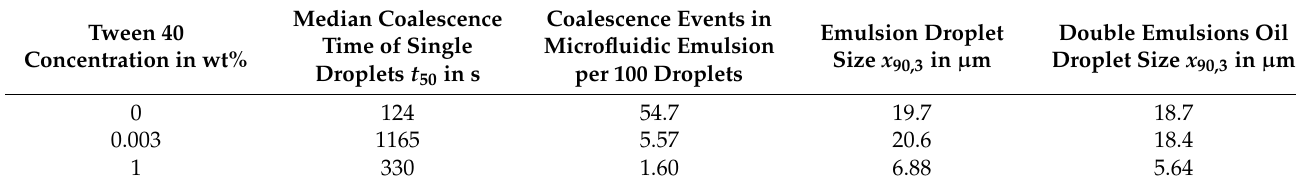
Table A4. Comparison of the effect of the three different measurement methods on the example of different Tween 40 concentrations with the addition of Span 80. For the microfluidic experiment, the values are from after 90 days and for the emulsification experiments, they are from after 14